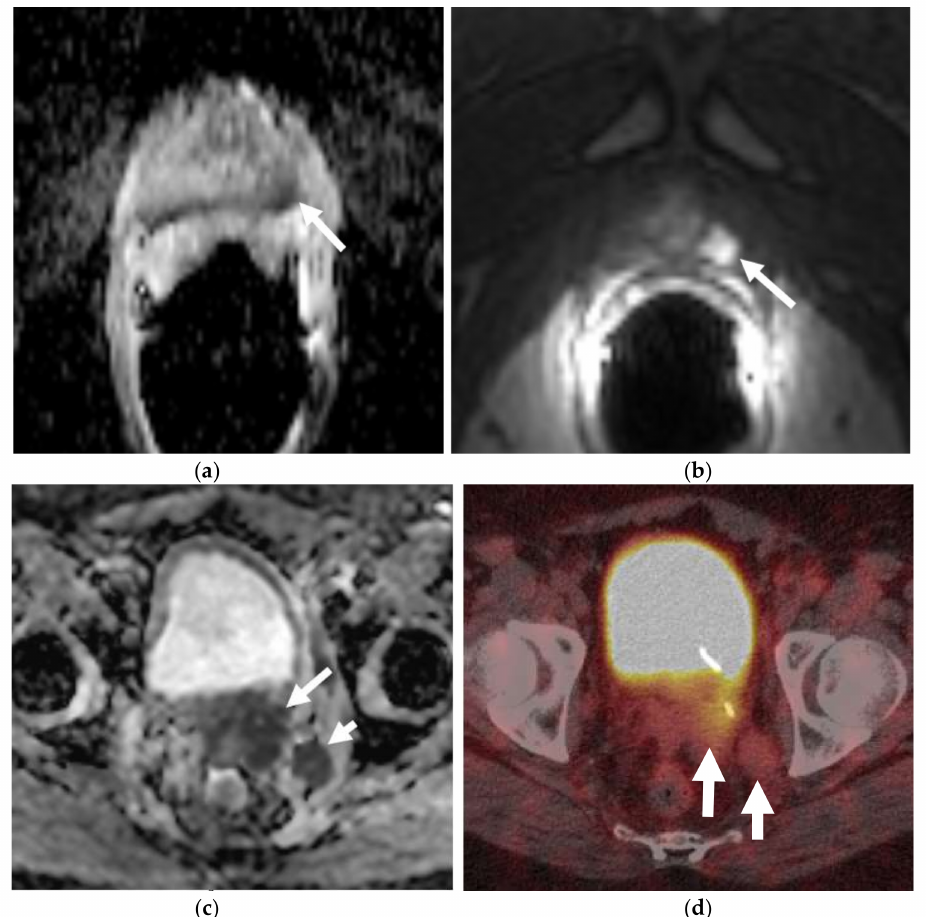
Figure 4. A 56-year-old male with prior hormonal therapy for 2 years and external beam radiation therapy for the biopsy-proven diagnosis of prostatic adenocarcinoma in 2008. Follow-up MRI pelvis performed for recurrent elevated serum PSA 6 years after shows a left posterolateral peripheral